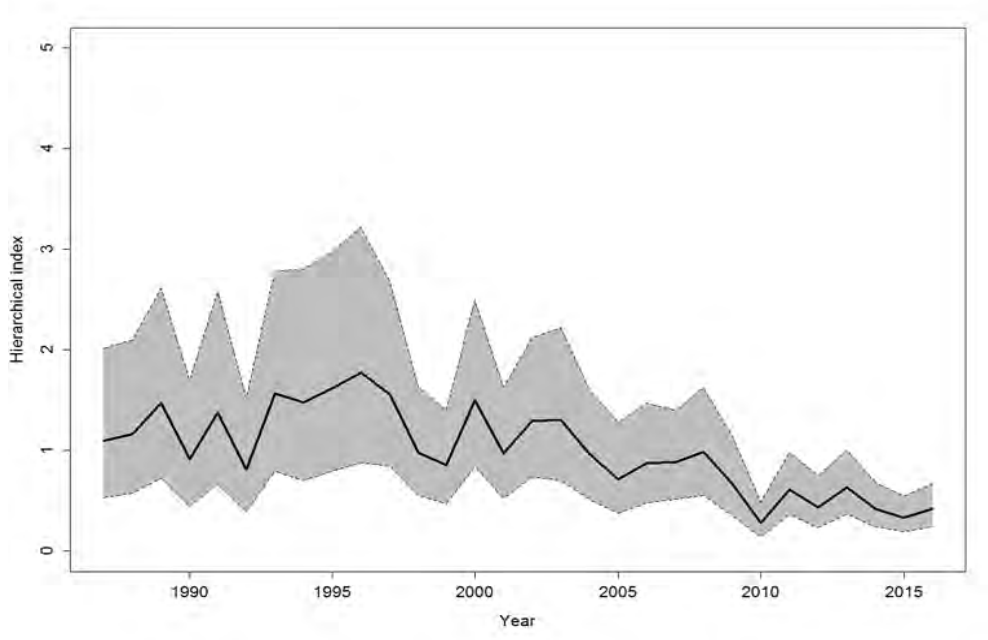
Figure 78. Time series of horseshoe crab relative abundance in the New York region as estimated from hierarchical analysis. The black line gives the posterior mean and the grey, shaded area represents a 95% credible interval about the time